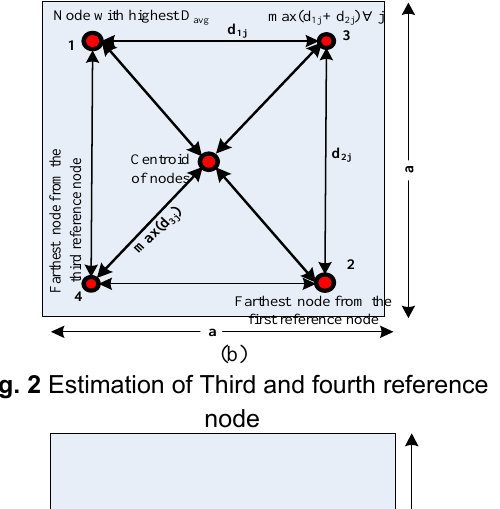
Fig. 2 Estimation of Third and fourth reference